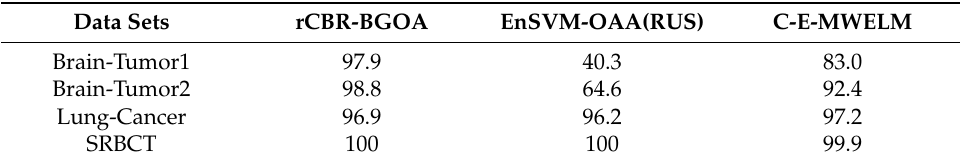
Table 9. G-mean predictive accuracy and compared with other state-of-the-art methods. Data